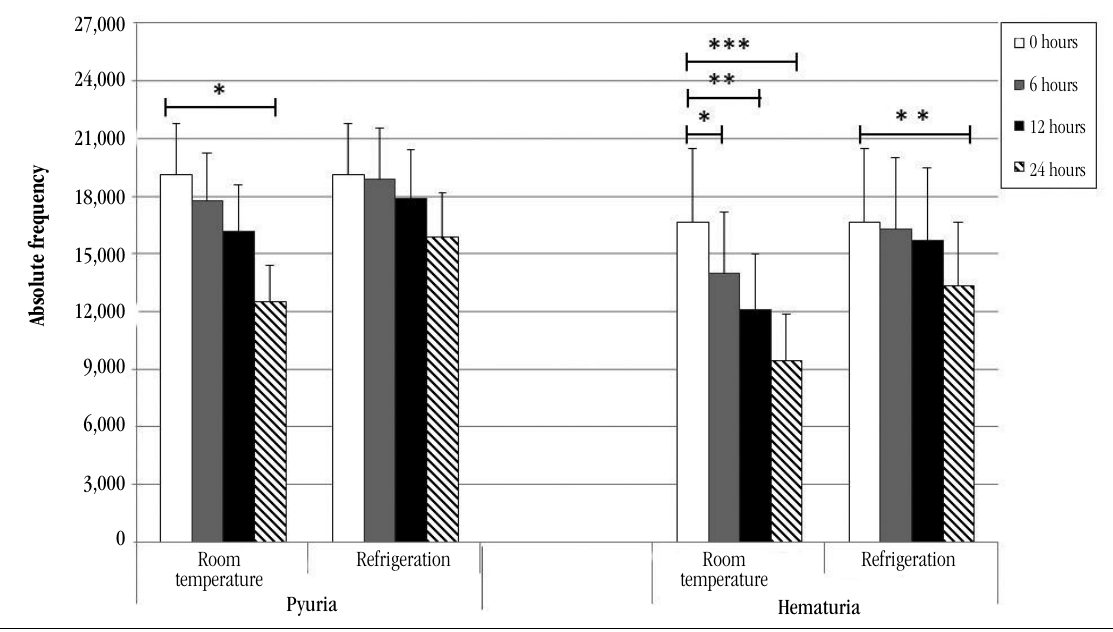
figurE 3 – Effect of urine storage at room temperature or under refrigeration for up 24 hours on quantified pyuria and hematuria 0 hours was the control group ( n = 20); stored for 6 hours ( n = 20); stored for 12 hours ( n = 20); stored for 24 hours ( n = 20). Data are presented as mean ± SD. *** p < 0.001; ** p < 0.01; * p < 0.05, always compared with the control